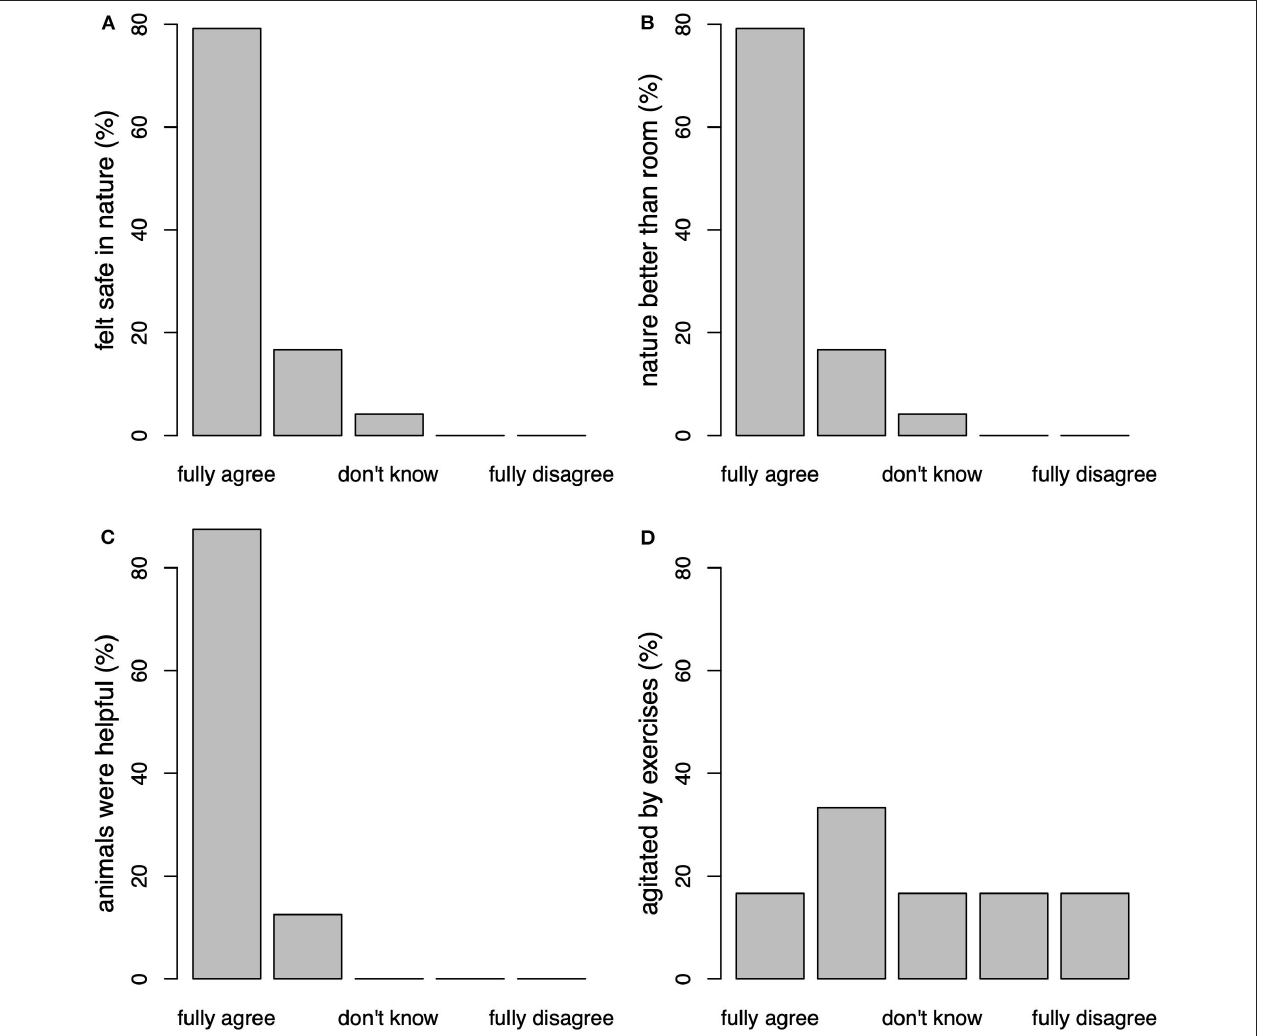
FIGURE 5 | Participants experiences with the NAM intervention (percentages of responses on each 5-point scale, total n = 24 for all scales). (A) “I felt safe and grounded because of the natural environment” (B) “I prefer a therapy program in nature rather than clinic rooms” (C) “Contact with the animals was helpful for me” (D) “At times I was agitated by the mindfulness